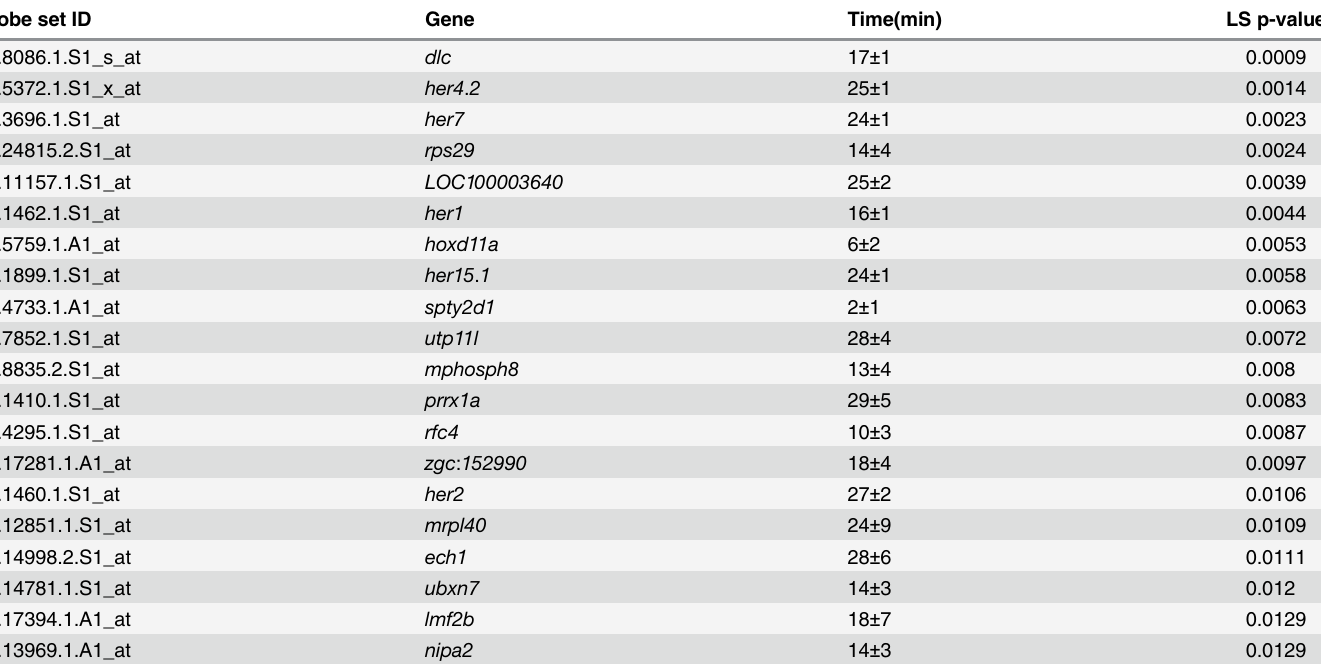
Table 2. Top 20 genes with one peak of expression during zebrafish somitogenesis. Times in minutes, assuming a 30mn periodicity, are provided for each peak. Accuracy has been estimated using a Monte Carlo method. All experimentally validated cyclic genes were detected using our algorithm (see